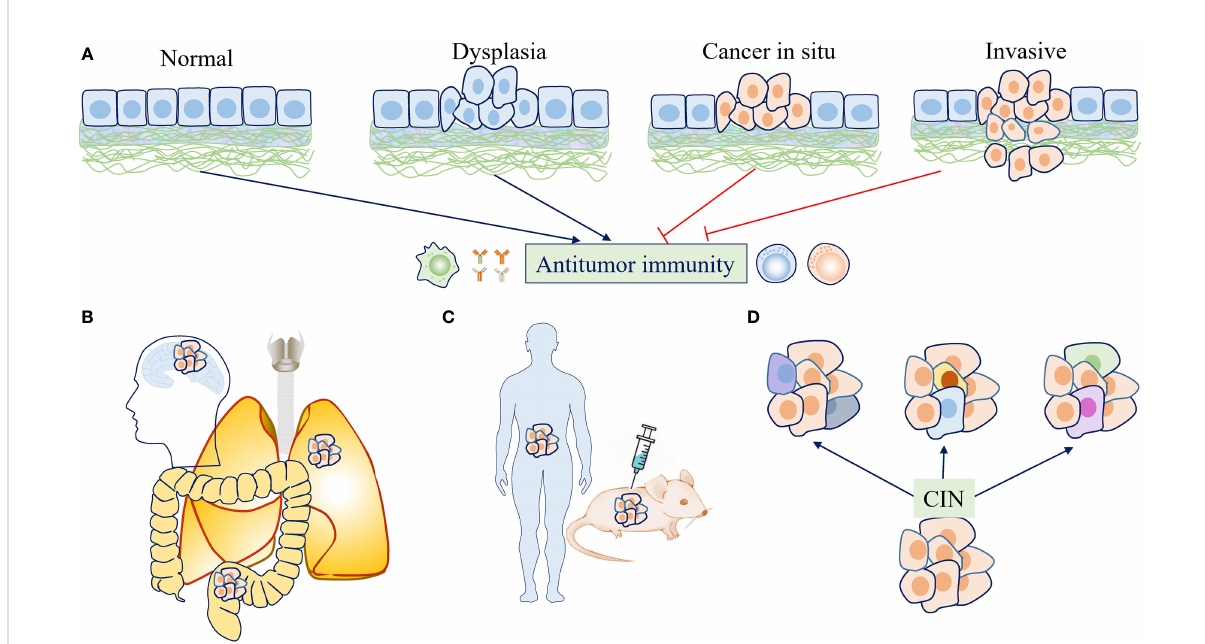
FIGURE 3 The effects of chromosome instability (CIN) and aneuploidy on antitumor immunity are context dependent. (A) At the early stage of tumor evolution, aneuploid cells were restrained by immunosurveillance. If the immune system has not eliminated these transformed cells completely, persistent CIN may continually produce “ new ” karyotypes, allowing the selection of cancer cells with the ability to escape immunosurveillance. (B) Tumors with different origins or locations may face different immune backgrounds and exhibit different immune in fi ltration, which plays a role in determining the effects of CIN/aneuploidy on antitumor immunity. (C) Various study designs and experimental conditions may lead to different fi ndings regarding the effects of CIN/aneuploidy on antitumor immunity. (D) CIN drives the development and maintenance of intratumor heterogeneity (ITH) as a stochastic generator for diverse karyotypes, which may also have different effects on immune responses due to karyotype-speci fi c consequences or different dosage alterations of gene